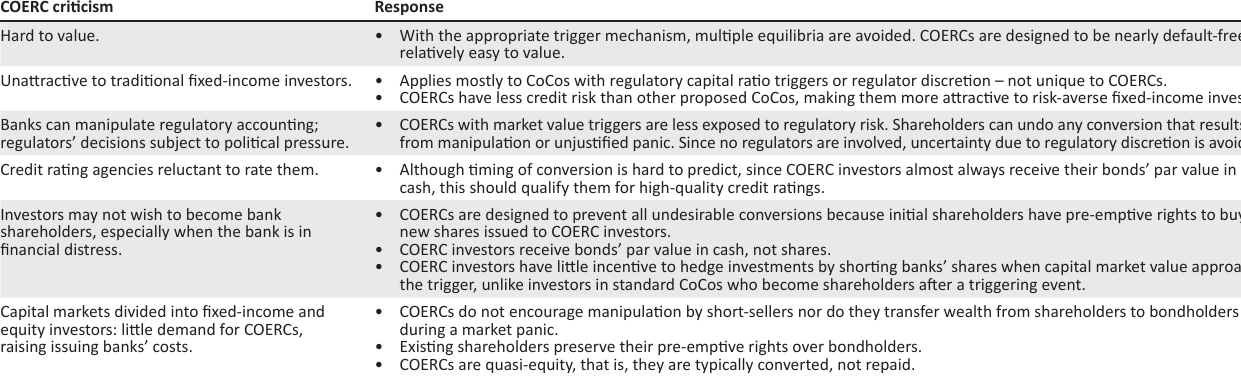
TABLE 3: Potential criticisms of Call Option Enhanced Reverse Convertible issuance and measured responses. COERC criticism